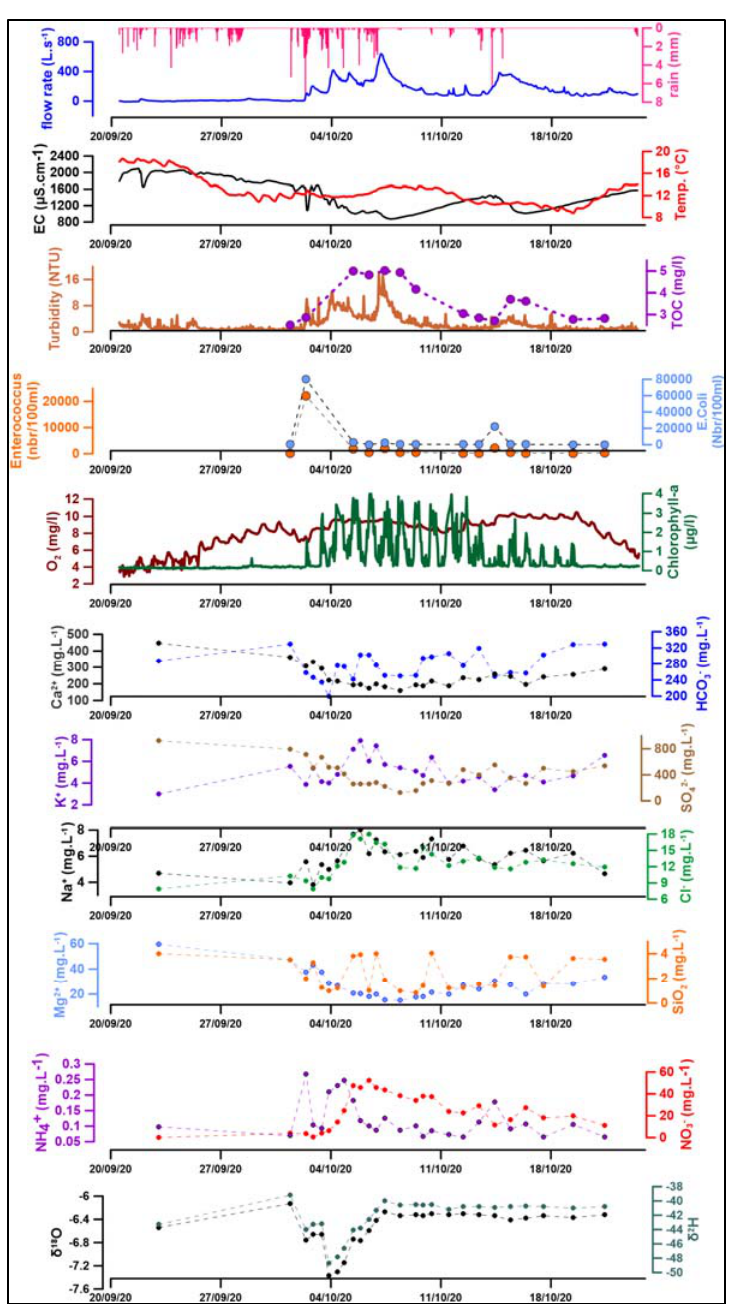
Figure B2. Chemiograph of the Azlou sink from 20/09/20 to 21/10/20. Figure A5. Chemiograph of the Azlou sink from 20/09/20 to